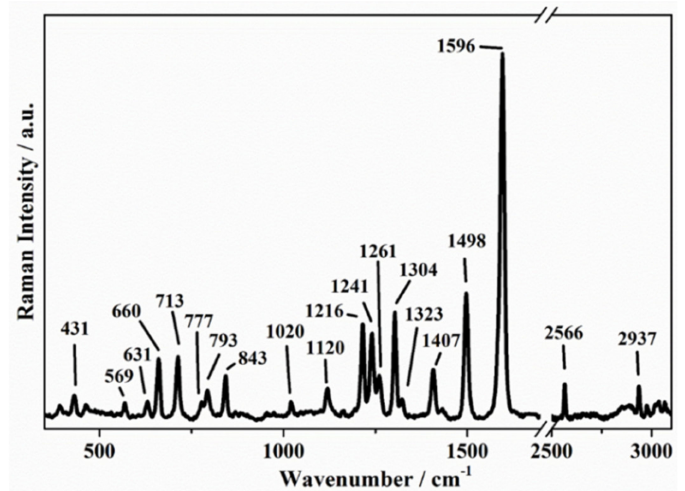
Figure 10. Raman spectrum of Bpy-SH in powder sample collected in the ranges between 350 and 1700 cm − 1 and between 2500 and 3100 cm − 1 (laser source at 532